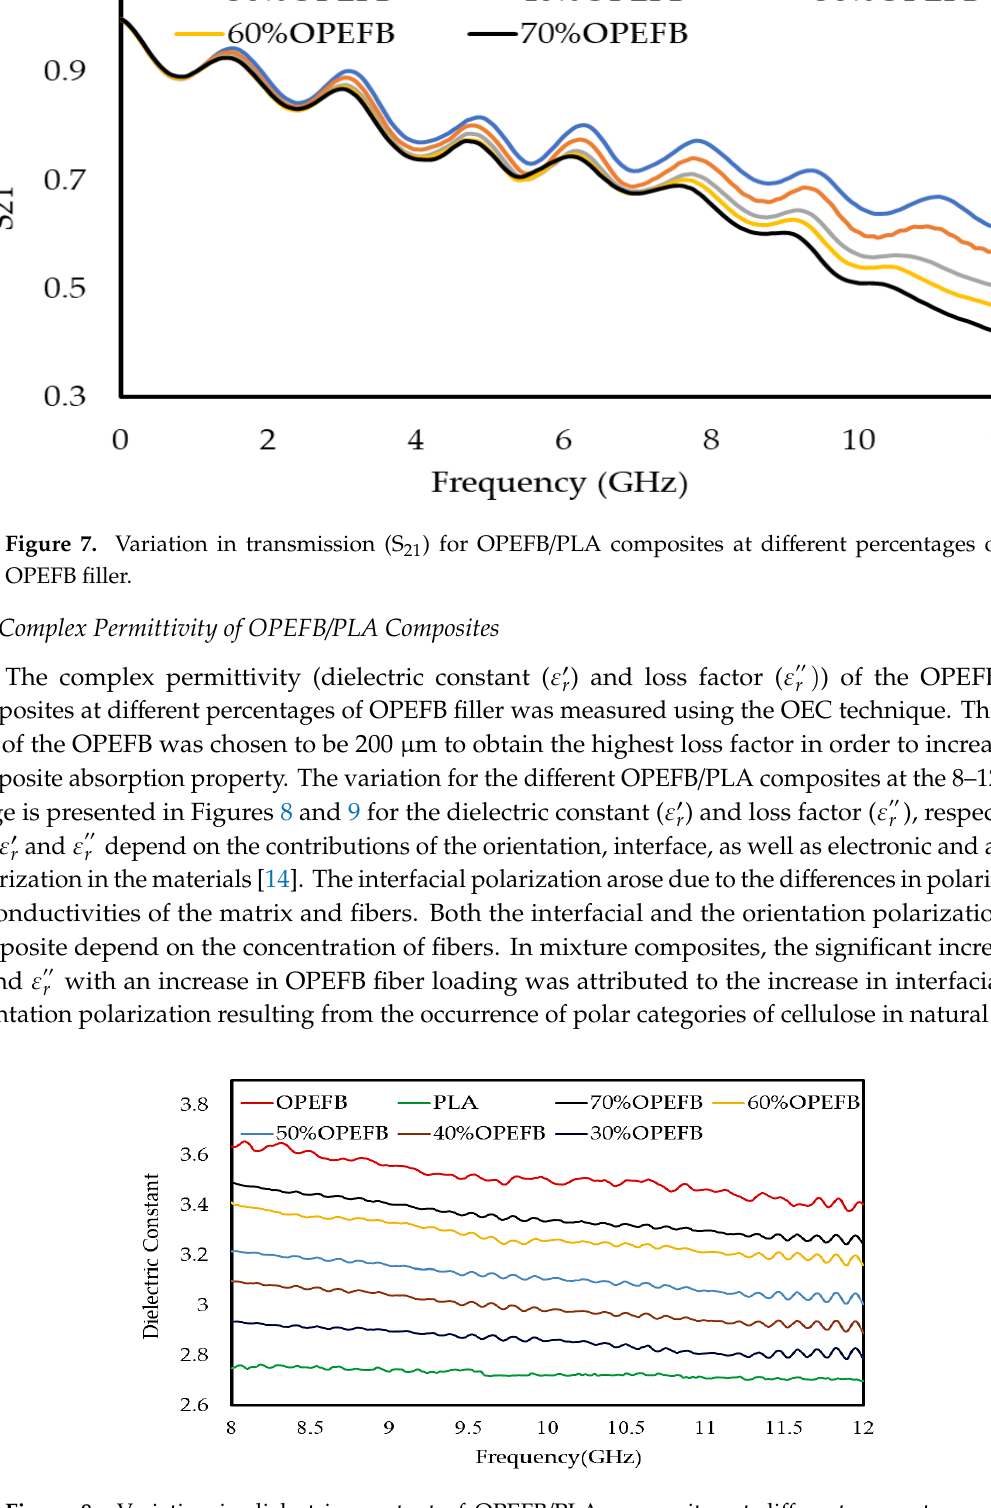
Figure 8. Variation in dielectric constant of OPEFB/PLA composites at different percentages of OPEFB filler.